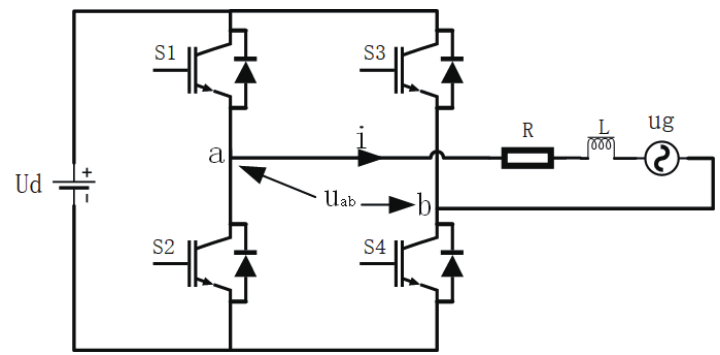
Figure 1. The topology of single-phase